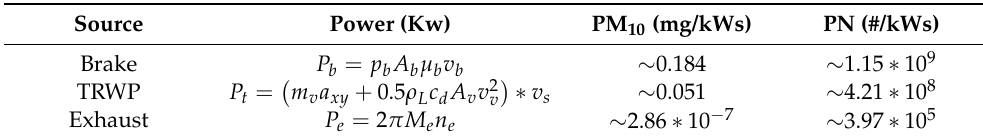
Table 1. Estimation of vehicle-related particle emissions (PM 10 and PN) as a function of power transmission.